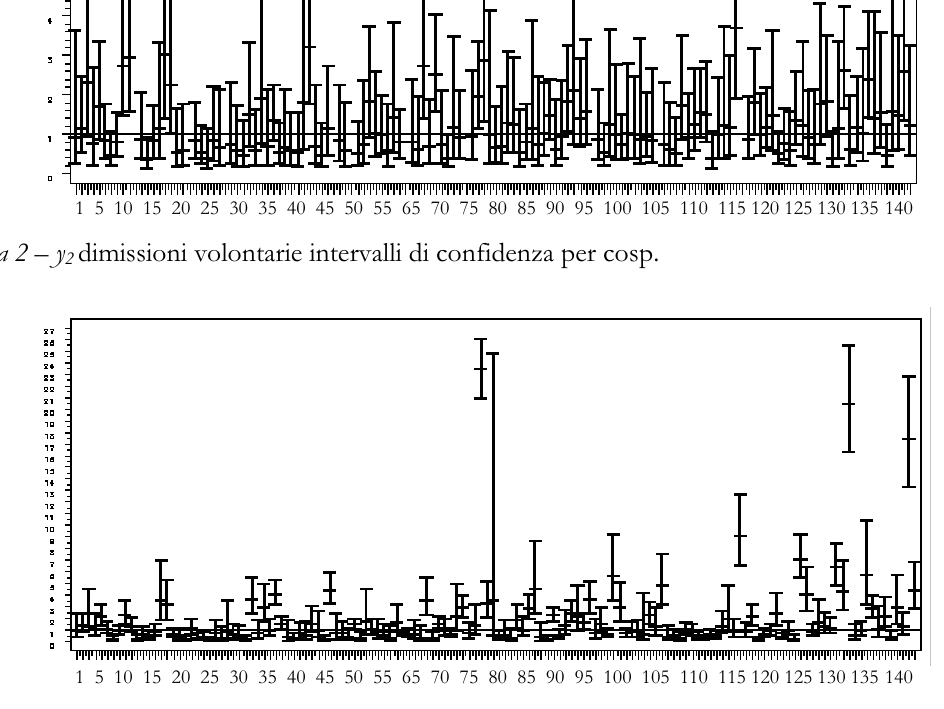
Figura 3 – y 3 trasferimenti tra strutture intervalli di confidenza per cosp. 59 Dato ad esempio da: utilizzo di un insieme di variabili esplicative capace di rappresentare in modo adeguato la variabilità degli ospedali; utilizzo dei residui per costruire graduatorie specifiche per indicatore; sintesi degli indicatori possibilmente stratificando per dimensione dell’area e pesando per complessità della casistica